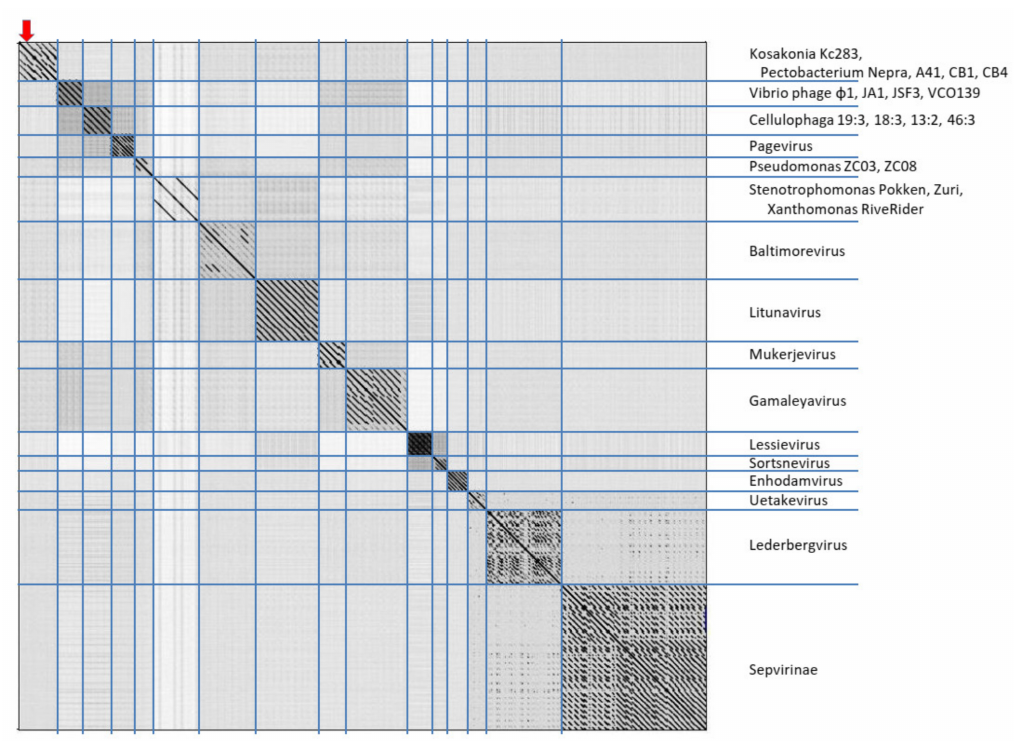
Figure 7. Dot plot of concatenated podovirus complete sequences generated in Gepard [22] with default parameters setting (word length = 10 and window size = 0). Position of Kc283 is marked.